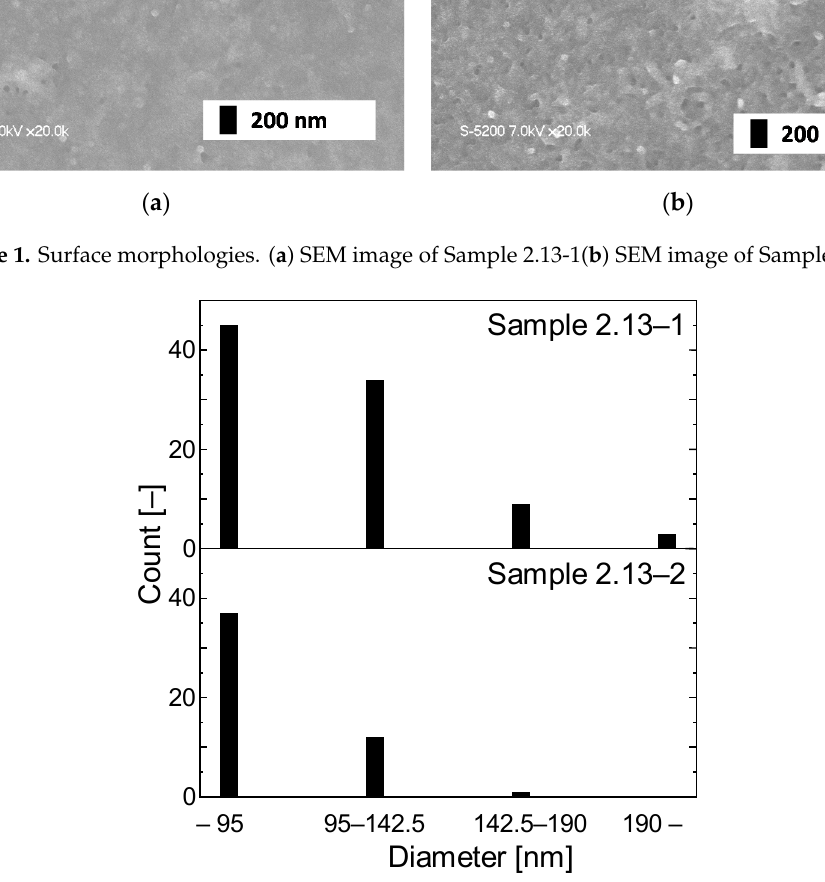
Figure 2. Histogram of palladium nano particles.